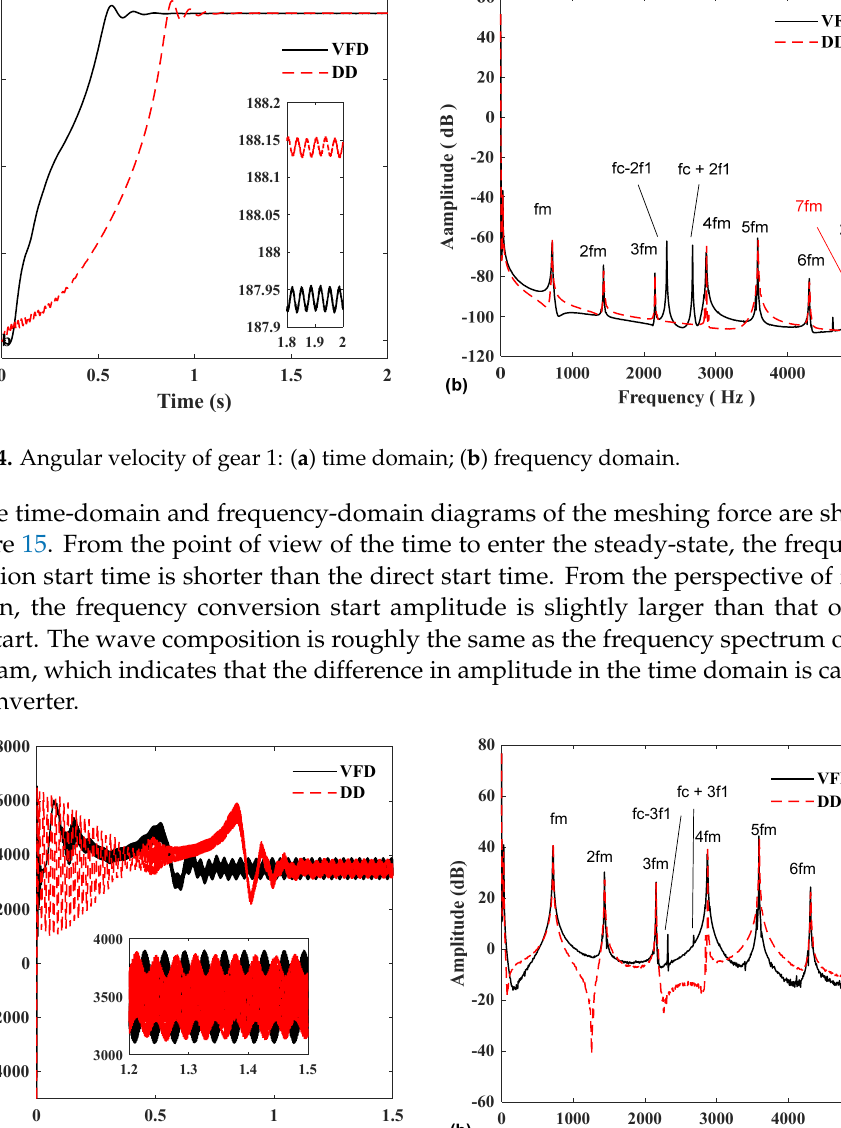
Figure 15. Gear1 − 3 mesh force: ( a ) time domain and ( b ) frequency domain. direct